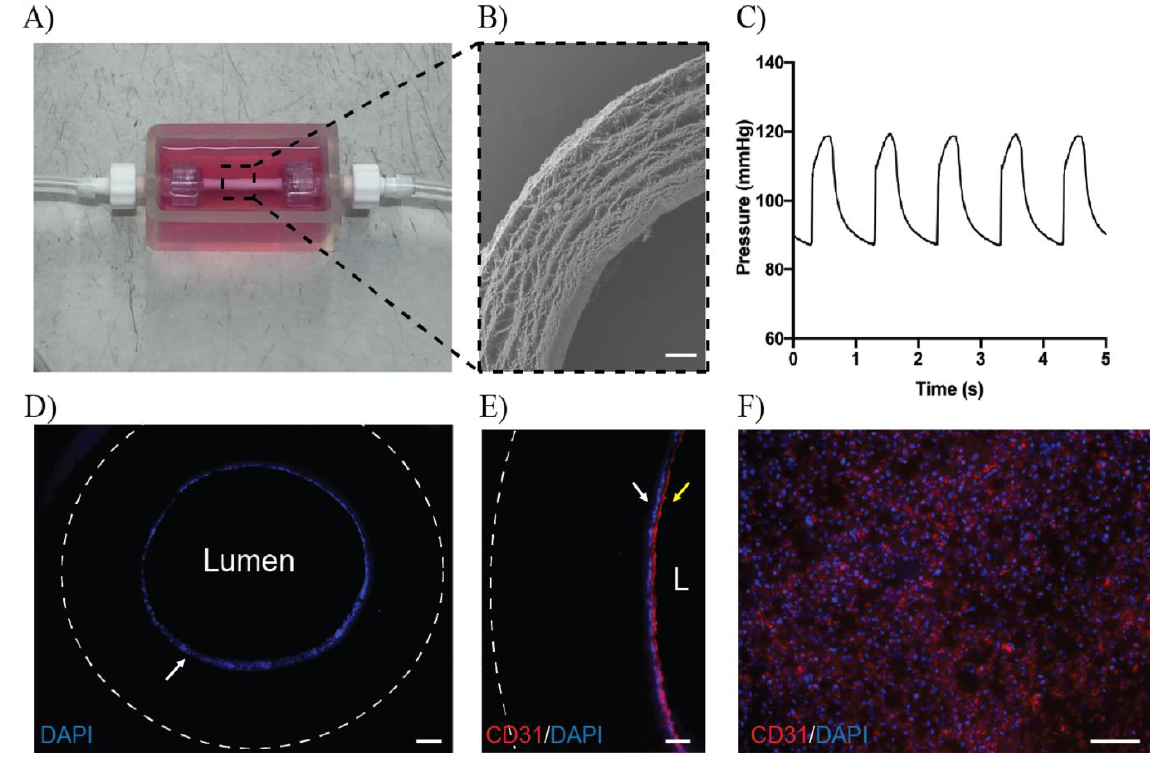
Figure 6. ECFCs rapidly form a confluent monolayer when grown in 3D under physiological conditions. ( A ) Vascular bioreactor Scheme 3. D cell growth on ( B ) fibrous PCL-gelatin scaffolds. Scale bar = 200 µm. ( C ) Seeded ECFCs were exposed to pulsatile pressure approximating human physiology. After 24 h, harvested grafts showed ( D ) a confluent monolayer of cells lining the graft lumen, staining positive for DAPI (White arrow, scale bar = 200 µm) and ( E ) CD31 (yellow arrow)/DAPI (white arrow). Scale bar = 50 µm. ( F ) Imaging of open graft sections supported the growth of a confluent layer of cells also staining CD31 positive. Scale bar = 100 µm.